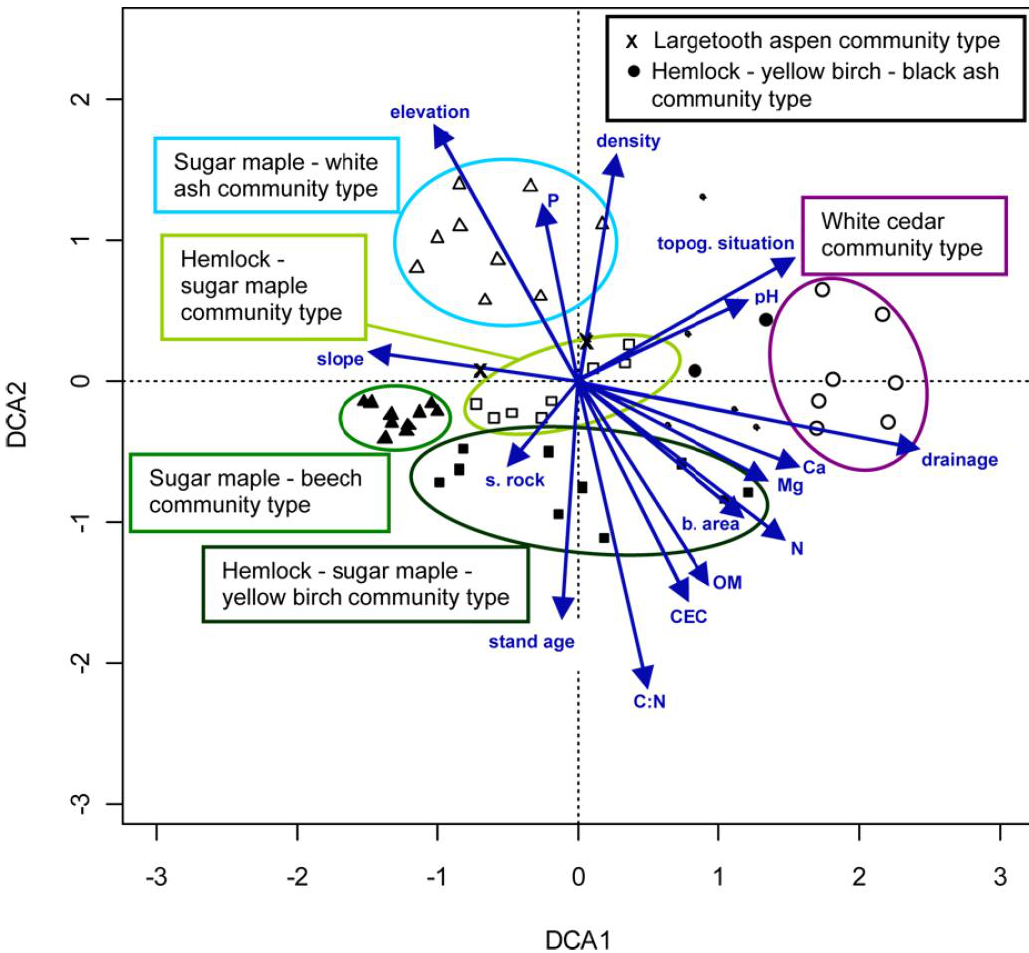
Figure 3. Detrended Correspondence Analysis (DCA) of a subset of 53 forest vegetation plots at St-Benoît-du-Lac Abbey. This second ordination was constructed with data from 53 plots of more typical forest vegetation plots that were not identified in the first ordination. Seven forest community types, that are generally more common in the study area and/or with older stand age, are identified. Five plots were not attributed to any specific community type (represented by small black dots). Ecological factors most strongly correlated with both axes are represented by vectors. Abbreviations: slope = percent slope; elevation = site elevation; P = soil P; density = tree density/ha; topog. situation = topographical situation; pH = soil pH; drainage = soil drainage class (rapidly drained to poorly drained); Ca = soil Ca; Mg = soil Mg; N = soil N; b. area = tree basal area/ha; OM = soil percent organic matter; CEC = soil cation exchange capacity; C:N = soil C:N ratio; stand age = age of largest trees; s. rock = percent surface rock